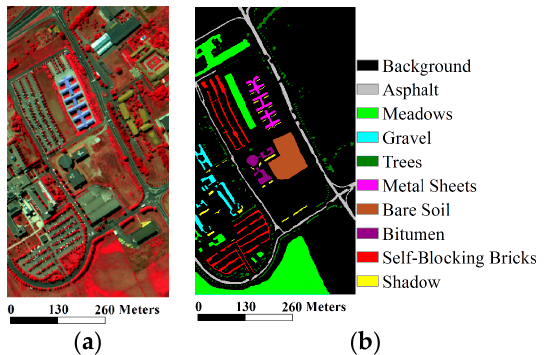
Figure 4. ROSIS-03 University of Pavia data set and the corresponding ground truth data: ( a ) three-band color composite image (bands 80, 50 and 30); and ( b ) ground truth data.